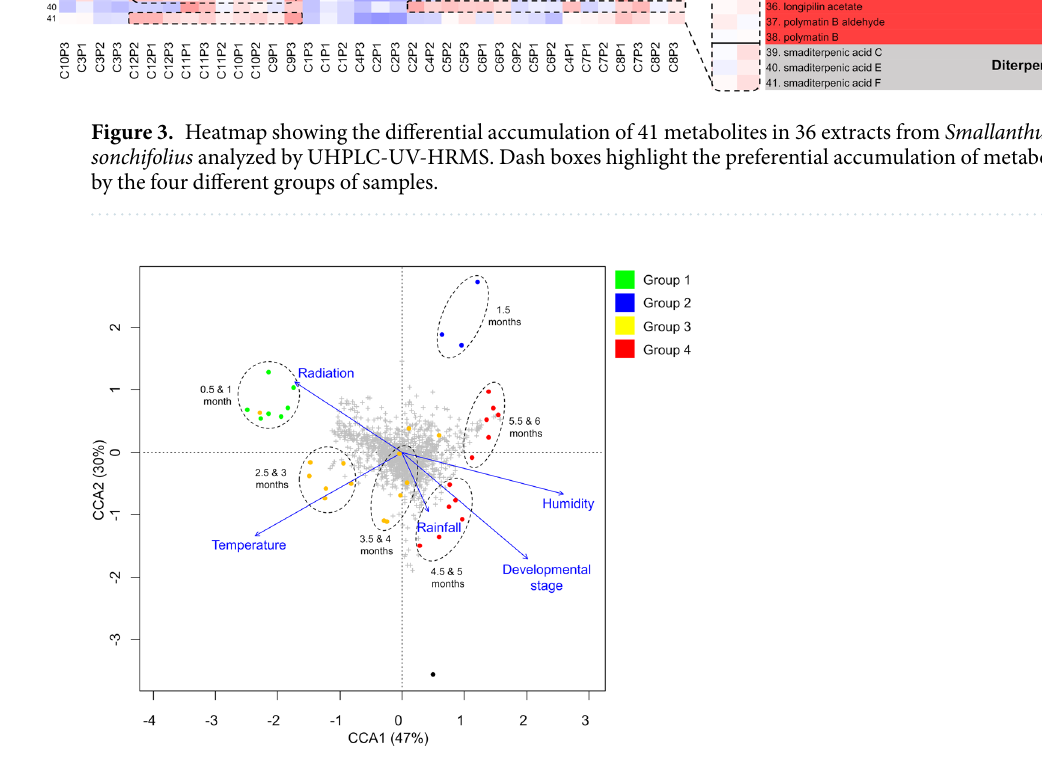
Figure 4. CCA based on metabolic fingerprinting by UHPLC-UV-HRMS in positive mode of 36 extracts from Smallanthus sonchifolius , showing the correlation of environmental factors and developmental stage with the clustering of samples by metabolic